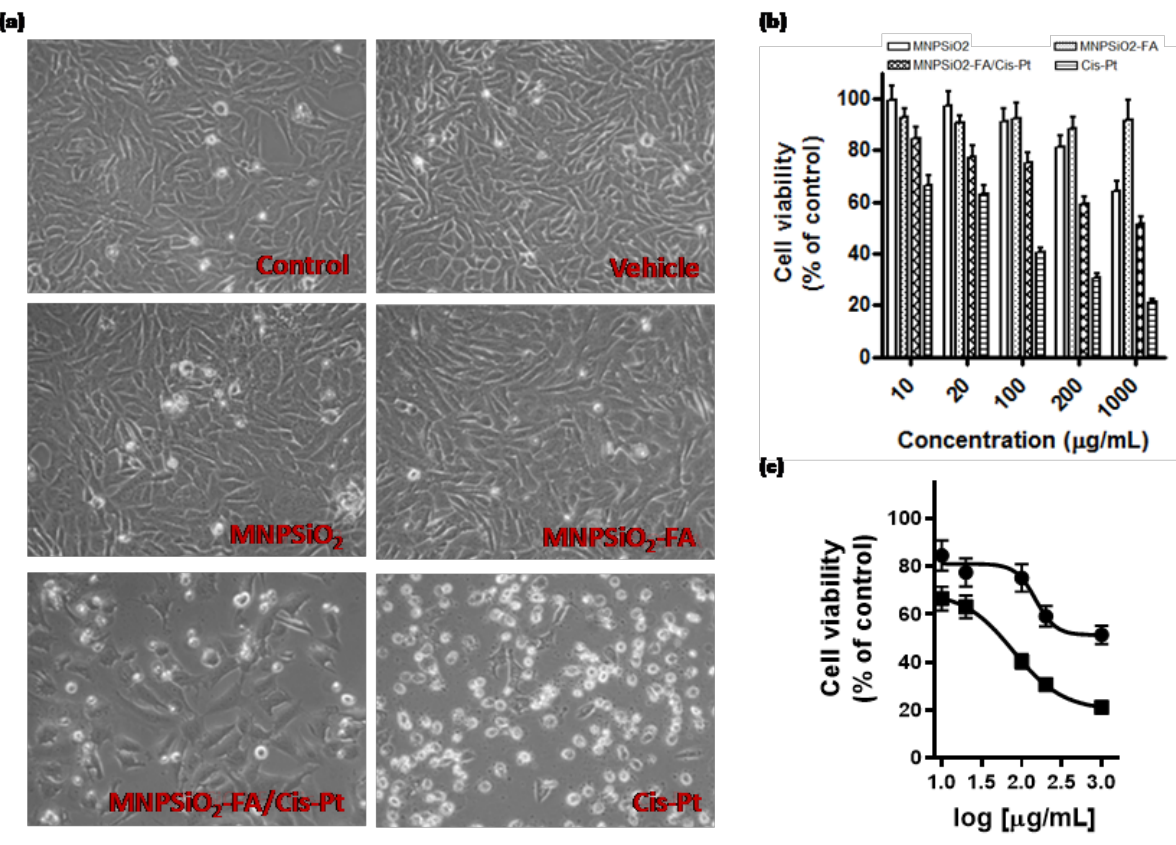
Figure 8: Cytotoxic effects of MNPs over cell viability: (a) LM photographs of LN18 cells. (b) Dose-response of mesoporous nanoparticles, (c) Dose-dependent curves of Cis-Pt (squares), and MNPSiO 2 -FA/Cis-Pt